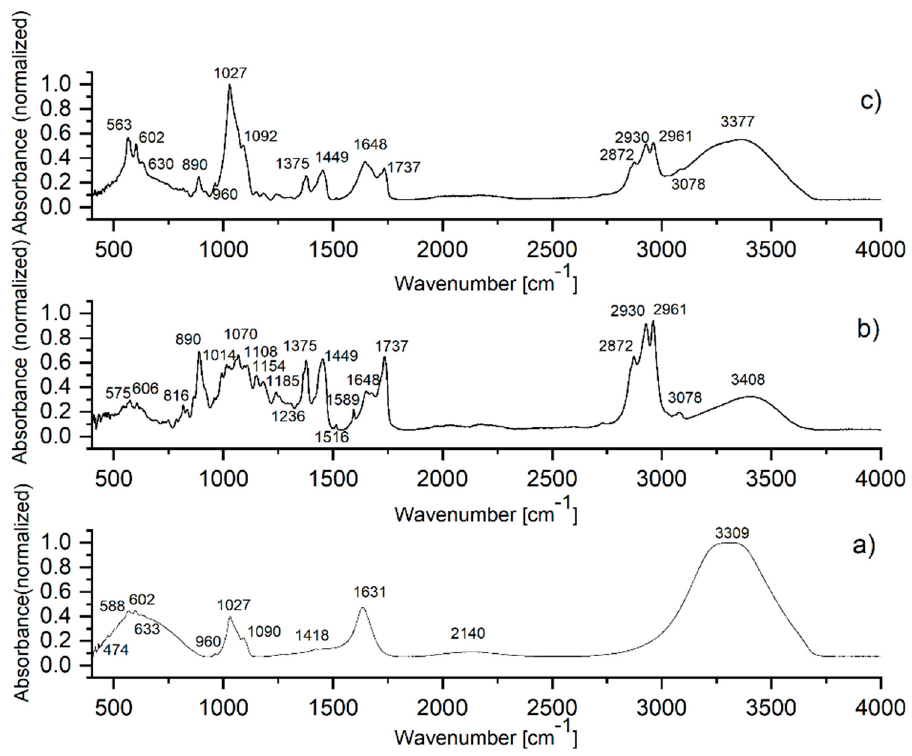
Figure 5. FTIR spectra of the HAp solution ( a ), WW EO ( b ) and HApWW ( c ) samples.